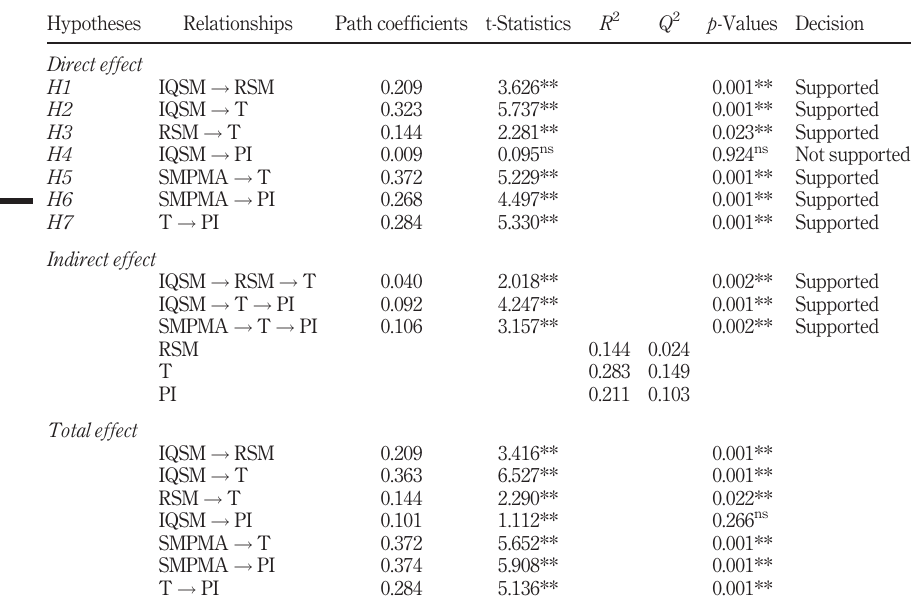
Table 4. Hypothesis